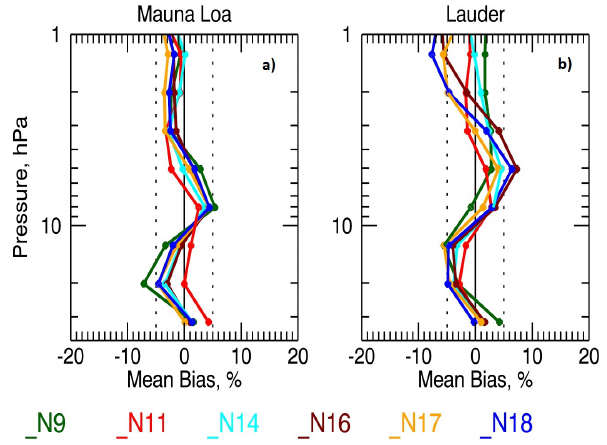
Fig. 6. Vertical profiles of mean biases for individual SBUV in- struments relative to coincident ground-based microwave measure- ments at (a) Mauna Loa and (b) Lauder. Colors correspond to indi- vidual SBUV instruments.